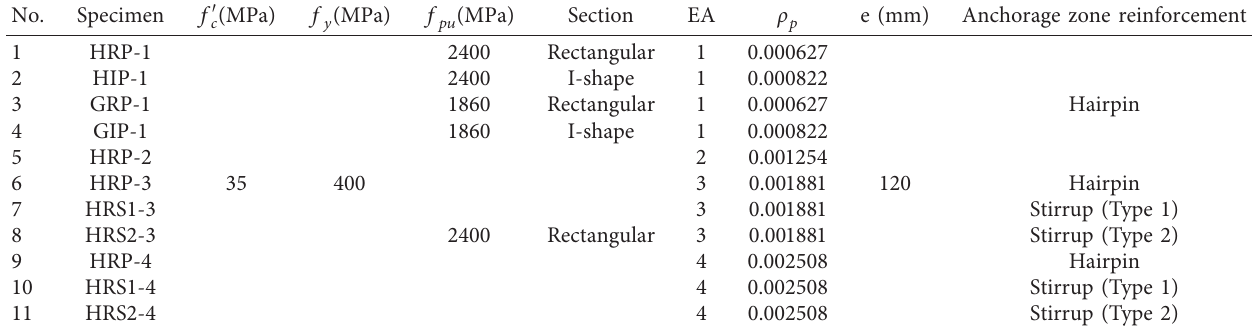
Table 2: Details of experiment specimens.